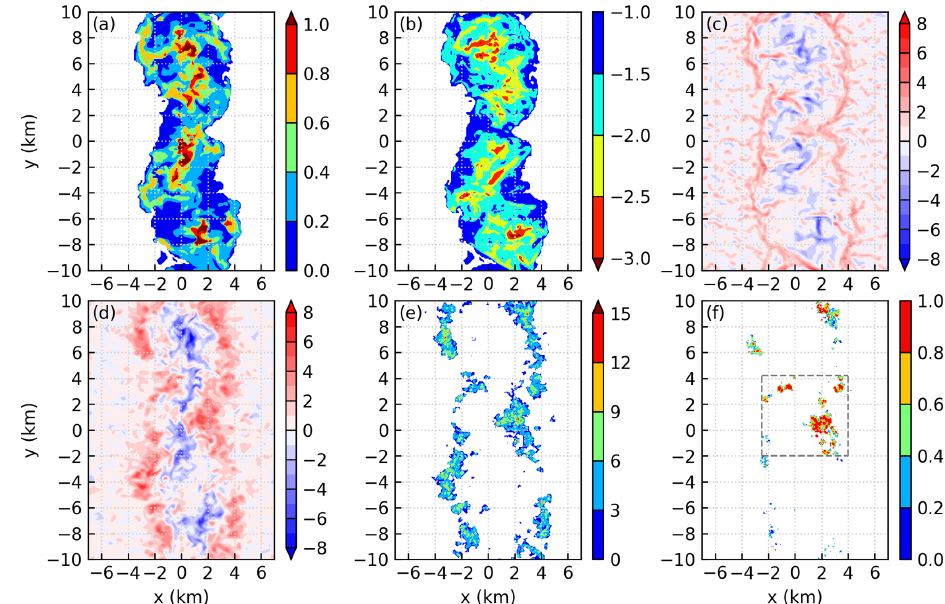
Figure 14. Panels (a) and (b) are, respectively, the depth (km) and temperature surplus (K) of the cold pools. Panels (c) and (d) are, respectively, the vertical velocity at z = 0 . 2 and 0.88km. (e) The number of parcels that are lifted at each grid point. (f) The fraction of parcels that rise above 8km in all parcels that are lifted. The gray rectangle encloses the parcel clusters that merge. The parcels are released at t = 8h 5min and tracked forward for 40min. The results are at t = 8h 17min of simulation